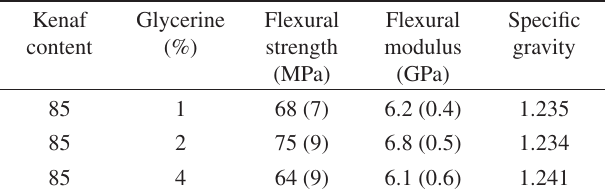
Table 1. Effect of amount of glycerine based on dry weight of fiber, on com- posite properties. (standard deviations in